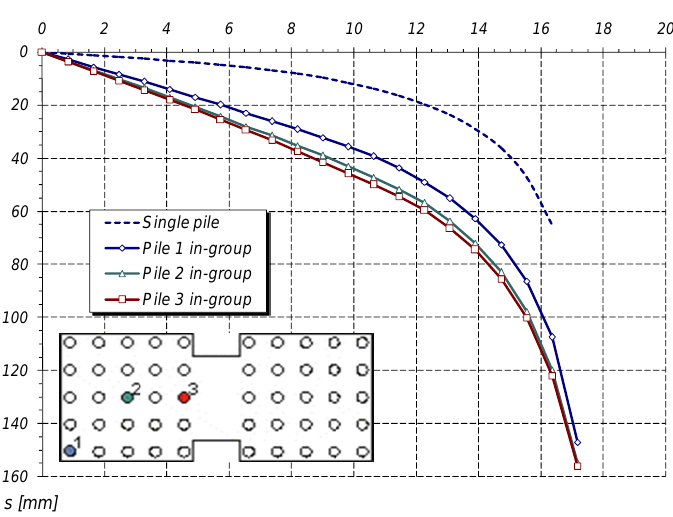
Figure 5. Example of load–settlement curves for piles in a group.